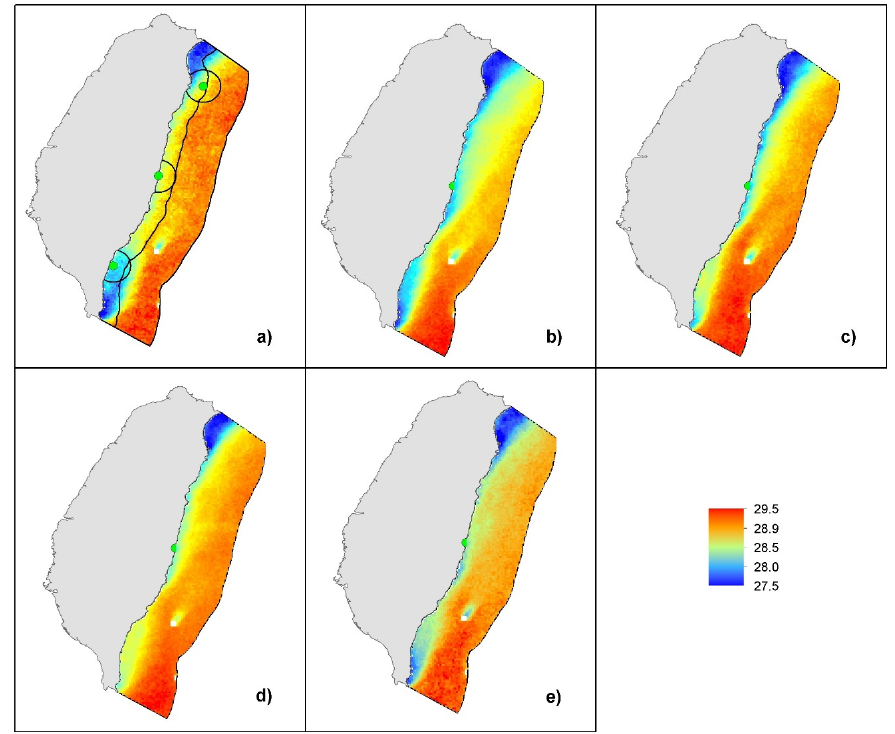
Figure 14. The annually-averaged SST maps were generated by combining the daily SST maps of the corresponding years; ( a ) 2015, (b) 2016, ( c ) 2017, ( d ) 2018, ( e ) 2019.